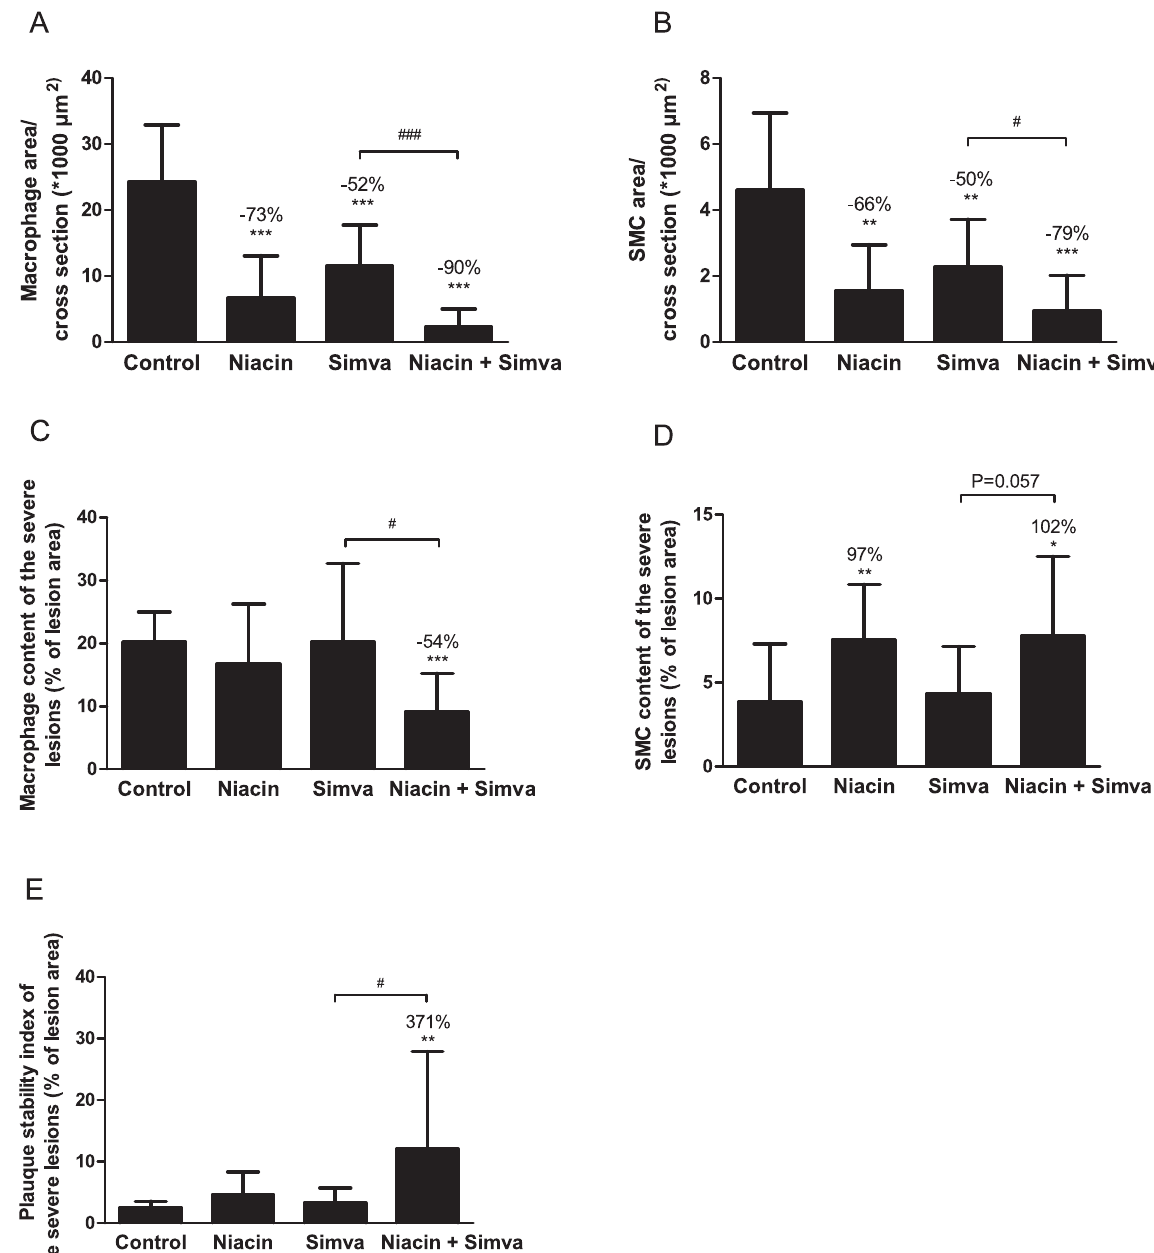
Figure 5. Effect of niacin, simvastatin and their combination on lesion composition. Macrophage area (A) and SMC area (B) were determined for all lesions and calculated per cross section. To correct for lesion size, macrophage content (C), SMC content (D), as well as plaque stability index (ratio of collagen and SMC content to macrophage content) (E) were also calculated as a percentage of lesion area, specifically in severe lesions (Type IV–V). (Simva, simvastatin; SMC, smooth muscle cells; values are means 6 SD; n=15 per group; *P , 0.05, **P , 0.01 and ***P , 0.001 as compared to control; # P , 0.05, and ### P , 0.001 as compared to niacin + simvastatin).